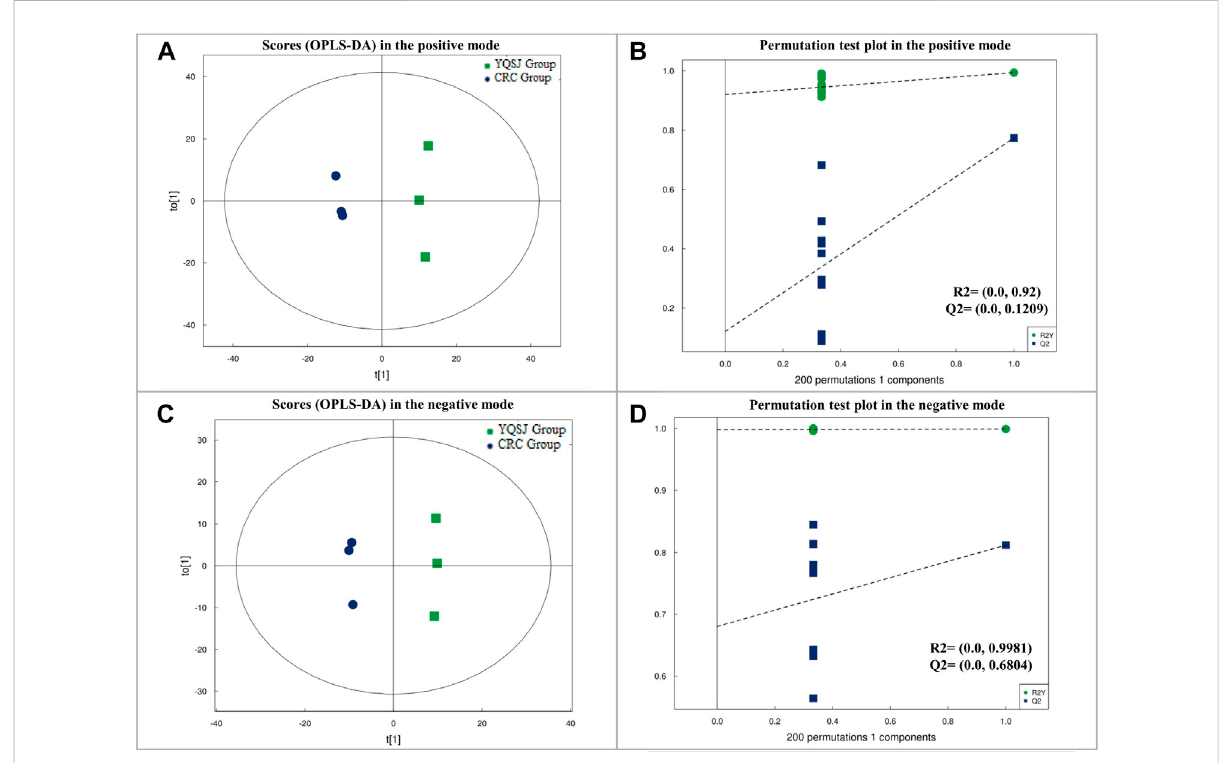
FIGURE 1 The results of OPLS-DA on metabolic data in the positive and negative modes, respectively. (A) Score plot in OPLS-DA model for colon tissue samples from CRC and YQSJ group in the positive mode. (B) Permutation test plot in OPLS-DA model for colon tissue samples from CRC and YQSJ group in the positive mode. (C) Score plot in OPLS-DA model for colon tissue samples from CRC and YQSJ group in the negative mode. (D) Permutation test plot in OPLS-DA model for colon tissue samples from CRC and YQSJ group in the negative